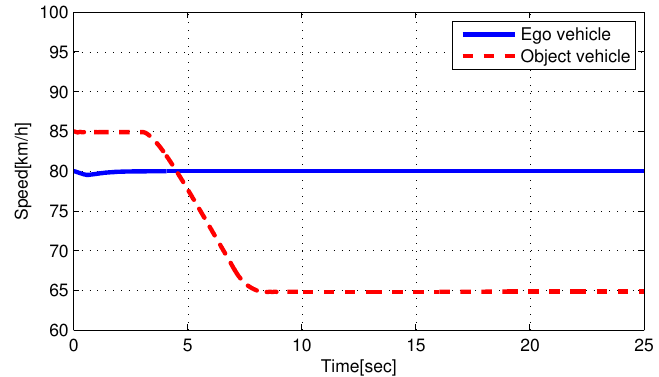
Figure 9. Velocities of ego and object vehicle of case 2.